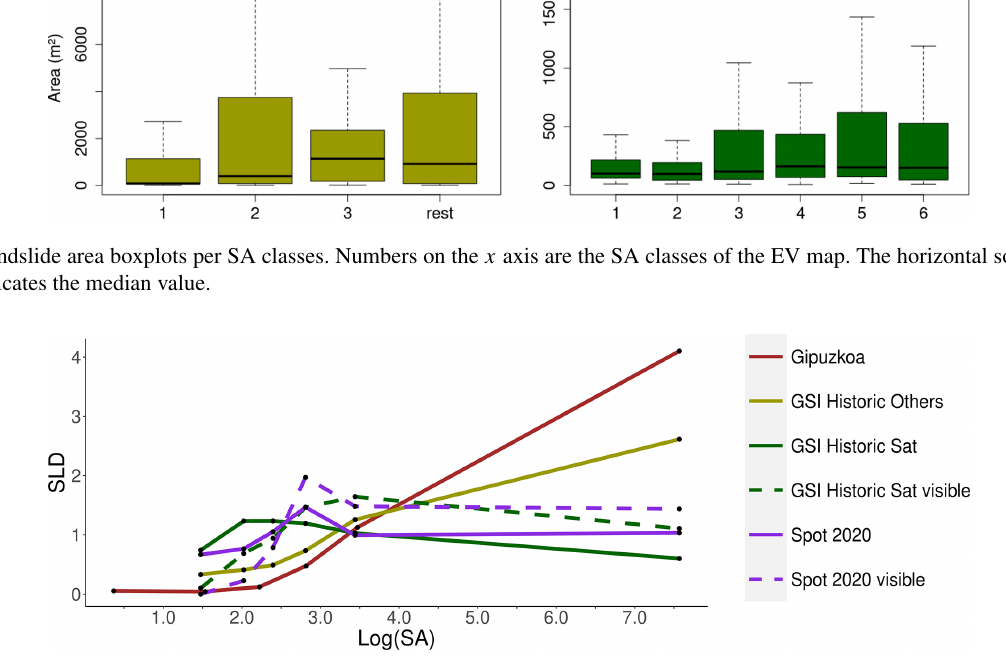
Figure 9. Standardised landslide density plot for six different landslide inventories. Spot 2020 visible and GSI Historic Sat visible are simulated sub-samples of Spot 2020 and GSI Historic Sat